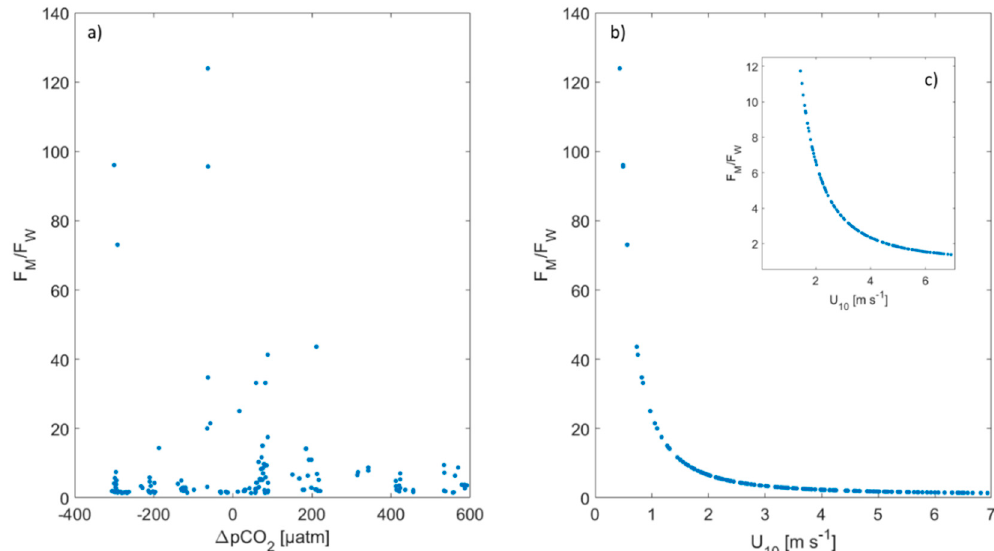
Figure 5. Ratio between flux calculated from the normally used parameterization (F W ) and from the parameterization with a nonzero intercept (F M ) versus ocean p CO 2 minus the atmospheric p CO 2 ( Δ p CO 2 ) ( a ) and the wind speed normalized at 10 m ( b ). The insert in ( b ) is the zoom for lower ratio to see the asymptote.